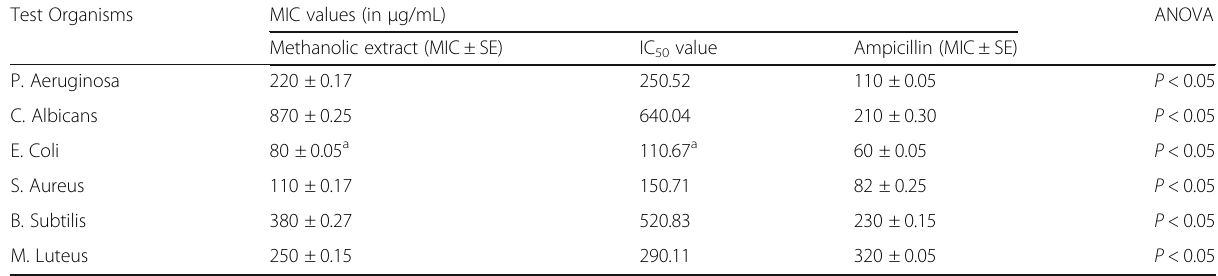
Table 3 Minimum Inhibitory Concentration (MIC) of methanolic extract of Bidens pilosa leaves Test Organisms